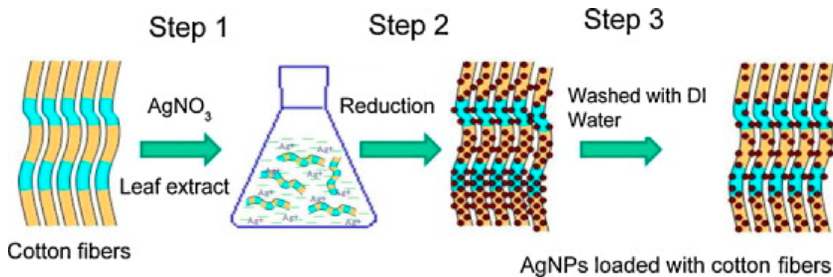
Figure 10. Illustration of AgNPs loaded cotton fibers via a three-step method. The leaching out with water leads to a decrease in the number of particles due to poor binding (Reproduced with permission from Reference